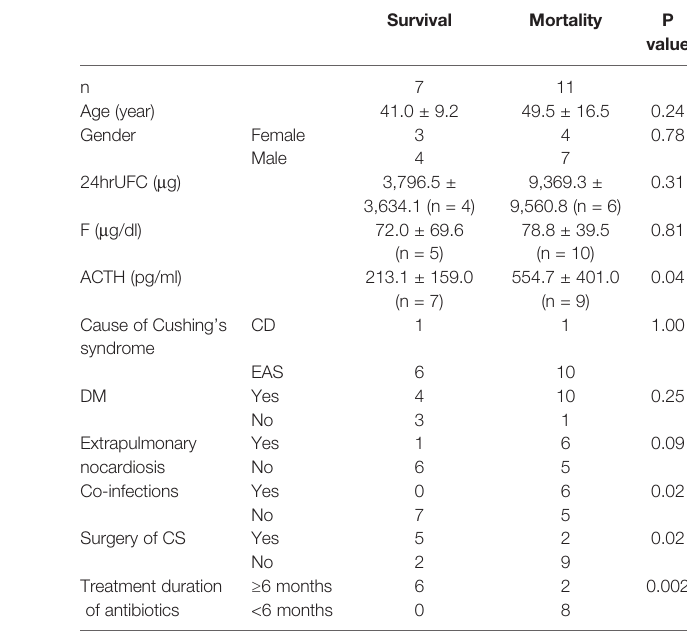
TABLE 2 | Comparison of clinical characteristics between distinct outcomes of patients of Cushing ’ s syndrome with